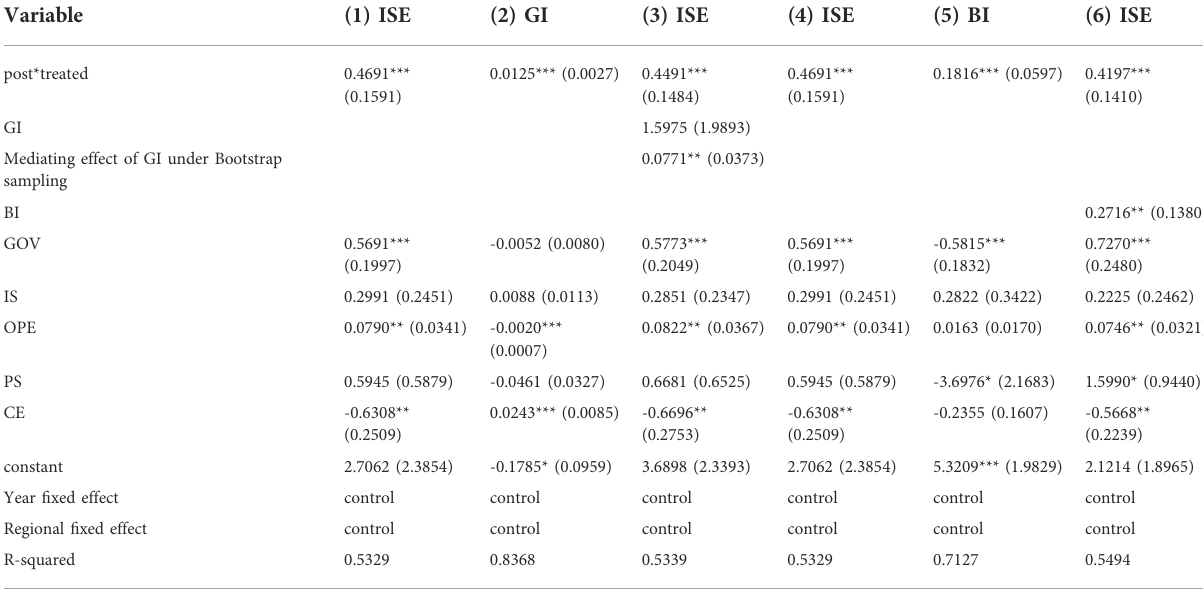
TABLE 9 Mediating effect of green innovation intensity and breakthrough innovation intensity.